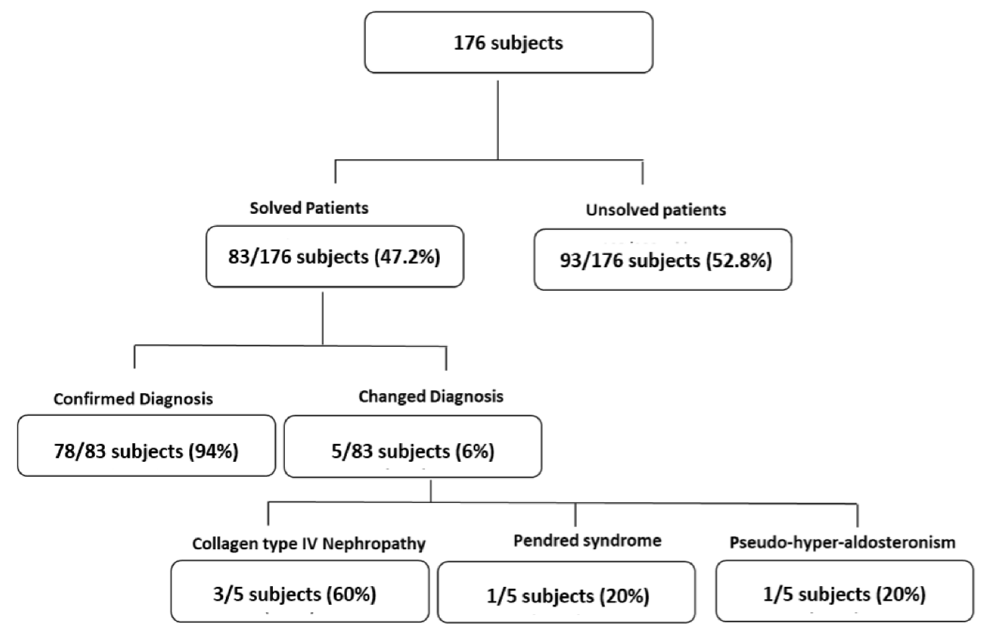
Figure 1. The cohort of patients undergoing NGS analysis, including patients that underwent confirmation and change/perfection of diagnosis after molecular screening.